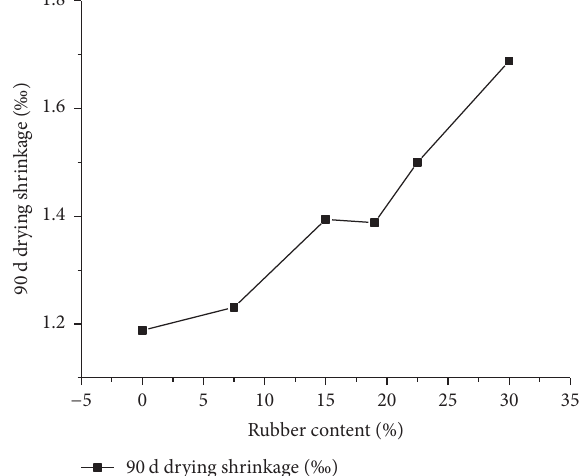
Figure 7: Mortar mixed with rubber particles flexural failure mode.